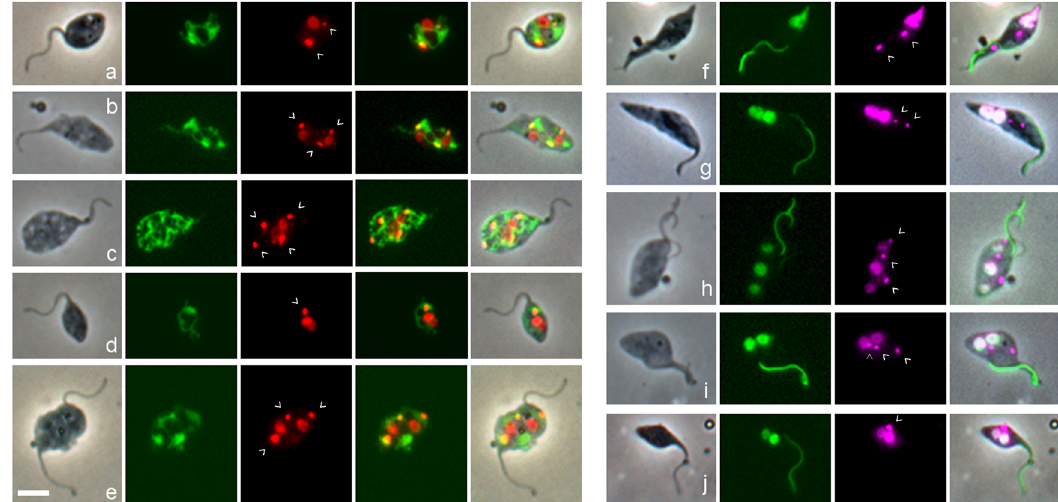
Fig. 3 Visualization of the mitochondrion and nucleus in gametes and potential meiotic intermediates. a – e In T. b. brucei 1738 Mito GFP , GFP is targeted to the mitochondrial lumen using the 24 amino acid import signal of frataxin. L to R: phase contrast, GFP, DAPI (red), merge GFP and DAPI, merge all. DAPI fl uorescence is coloured red to visualize yellow (i.e. dual red and green) fl uorescence of the kinetoplast within the mitochondrion in the merged images. Kinetoplasts are indicated by arrowheads. a 2K1N gamete ; b 3K2N intermediate; c 4K2N intermediate; d 1K2N intermediate; e 3K2N intermediate with two fl agella. f – j T. b. brucei 1738 H2B::GFP YFP::PFR , fusion proteins visualize the nucleus and the para fl agellar rod (PFR) in the fl agellum respectively. L to R: phase contrast, GFP, DAPI (magenta), merge. f 2K1N meiotic divider with very large posterior nucleus; the paler PFR belongs to the new fl agellum; g 2K2N intermediate; h 3K3N intermediate; i 3K2N intermediate; j 1K2N intermediate. Scale bar = 5 µ